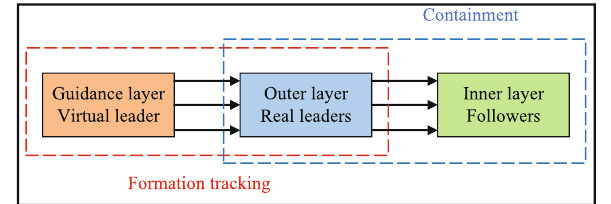
Figure 1. Three-layer structure